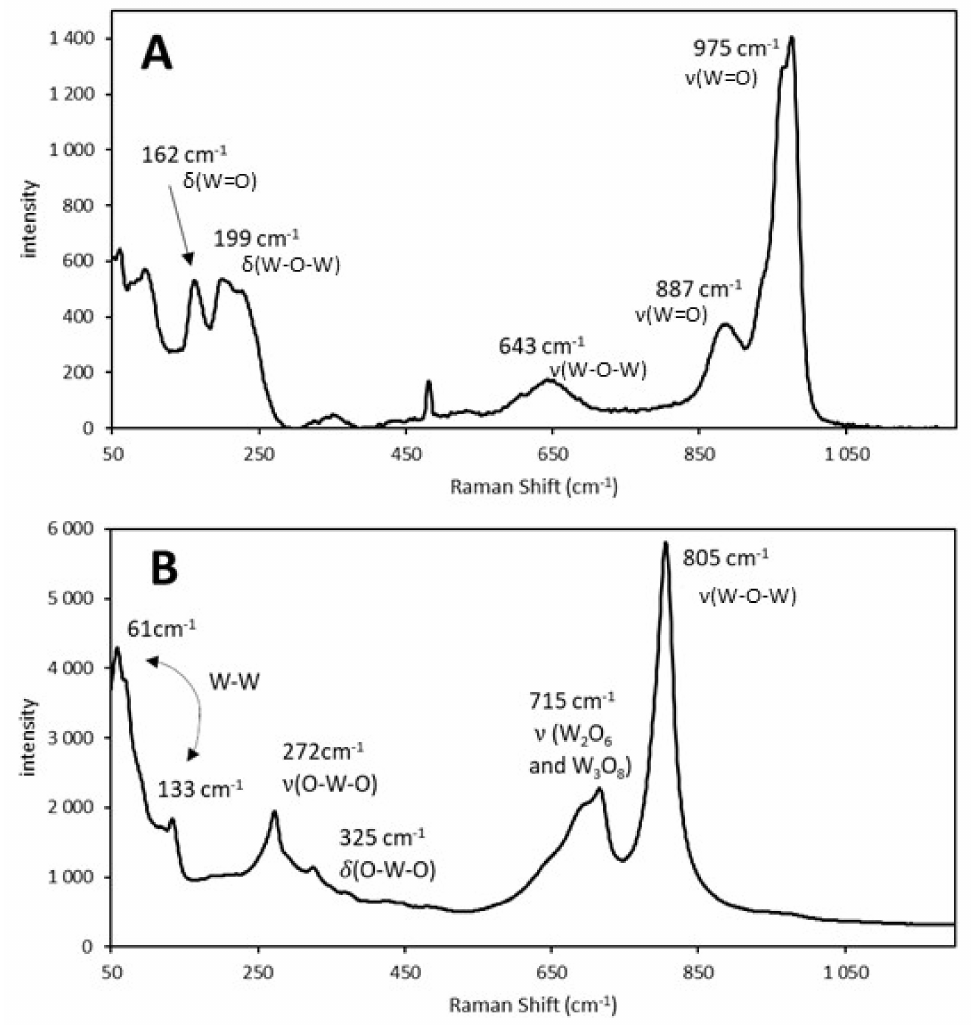
Figure 5. Raman spectra of the W-supported mesoporous silica catalyst with a W content of 40 wt% ( A ) before calcination (ammonium metatungstate) and ( B ) after calcination at 500 ◦ C for 4 h (tungsten oxide). A 532 nm laser was used to excite the samples. Here, δ and ν denote bending and stretching vibrations, respectively